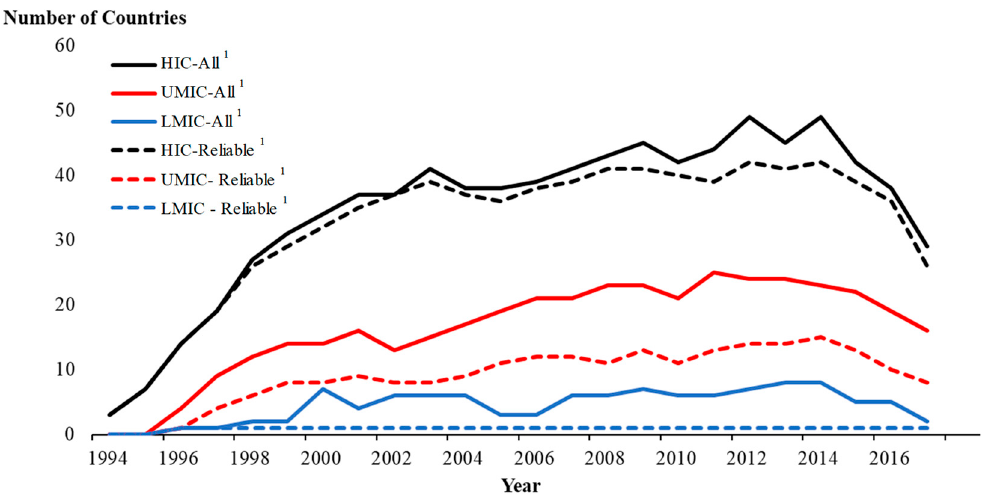
Figure 1. Trend over time in number of countries reporting mesothelioma deaths to the WHO by national income category 1 and data reliability 2 .HIC: High income countries; UMIC: Upper middle-income countries; LMIC: Lower middle- and low-income countries combined (See Table 2 and text for exact definition of national income category). 1 All countries reporting mesothelioma deaths to the